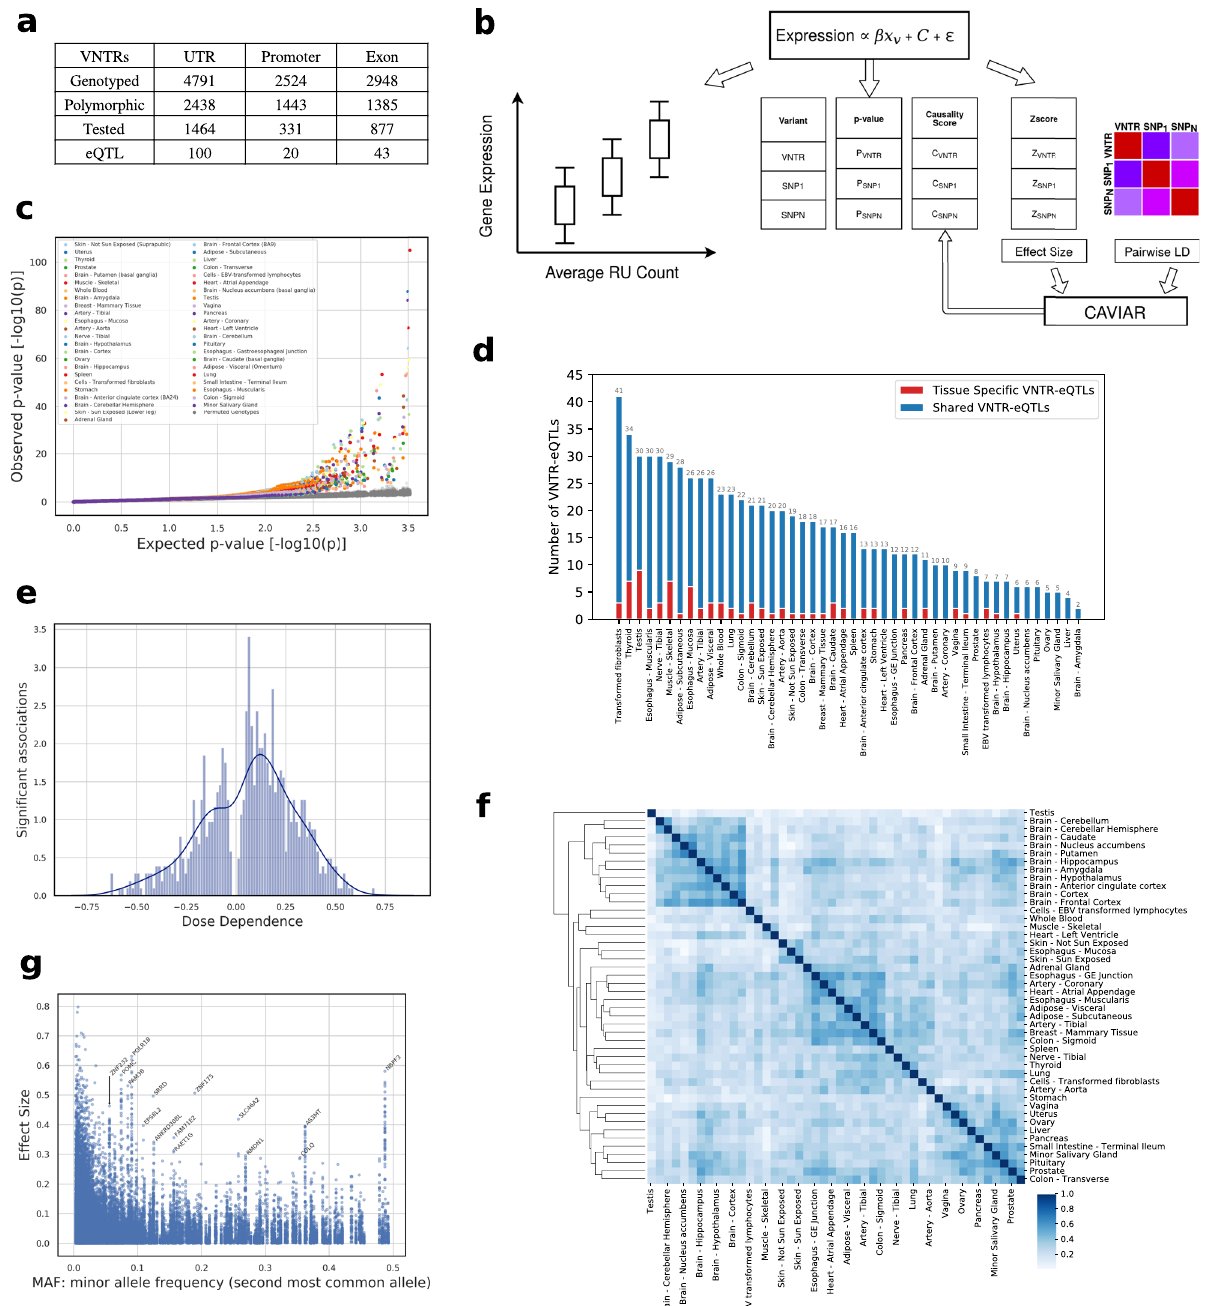
Fig. 2 Effect of VNTR genotypes on mediating gene expression. a Location of target VNTRs and eVNTRs relative to the proximal genes. b Pipeline to identify eVNTRs and assign causality scores. Ancestry, Sex, and PEER factors are included in C as covariates. We associate VNTR genotype with expression residuals after correcting for the effect of C . c Quantile-quantile plot showing p values of association signals separated by tissue. Green line represents the p values using 100 permutations. d Number of unique and shared eVNTRs in each tissue. e Trend of RU count correlation with gene expression level. f Spearman correlation of eVNTRs effect sizes for each pair of tissues. g Scatter plot correlating effect size versus minor allele frequency (MAF). Source data are provided as a Source Data fi included sex and population principal components (PCs) of each individual as covariates. We also added PEER (probabilistic estimation of expression residuals) factors to account for FDR cutoff (Supplementary Fig. S13 and Methods). Combining experimental variations in measuring RNA expression levels data from all tissues, 759 tests tied to 163 unique VNTR loci (e.g., batch effects, environmental variables) 43 . Brie fl y, PEER infers hidden covariates in fl uencing gene expression levels, and passed the signi fi cance threshold (Fig. 2c). We refer to these we removed their effect by producing a residual gene expression (VNTR, gene) pairs as eVNTRs. Unlike VNTRs that failed HWE matrix and using it for linear regression (See Methods). (median length: 92 bp), eVNTR allele lengths were much smaller